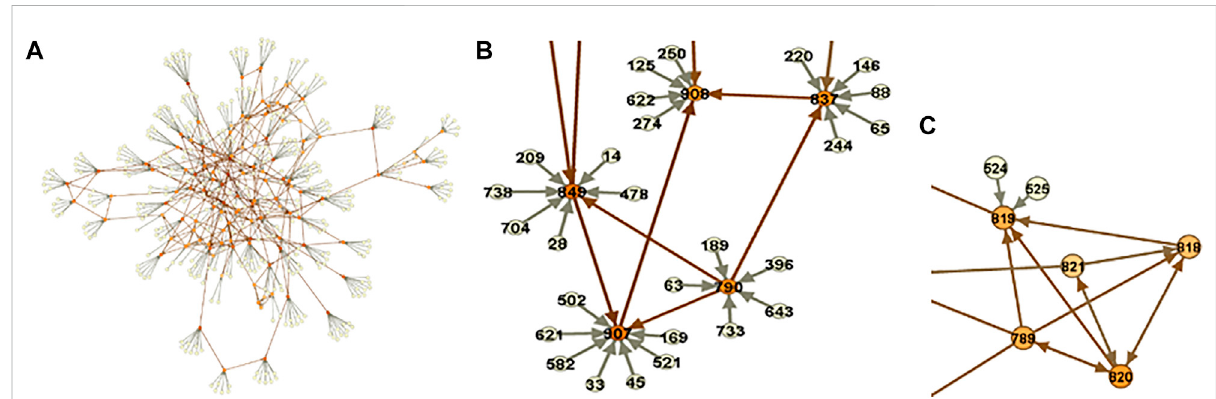
FIGURE 5 Metabolomic-causal network. (A) . In total, 325 polygenic factors satis fi ed MR assumptions/valid IVs (pale nodes) and were used to facilitate the identi fi cationofthecausalnetworkof122metabolites(orangenodes). (B). Aclose-upofthenetwork. (C). Apartofthenetworkwithnogenome IV a result, some of the causal relationships are not identi fi ed, depicted as bi-directed links. Interestingly, we noticed that the corresponding metabolites are dietary-related metabolites that are mostly in fl uenced by environmental factors and not genetics.